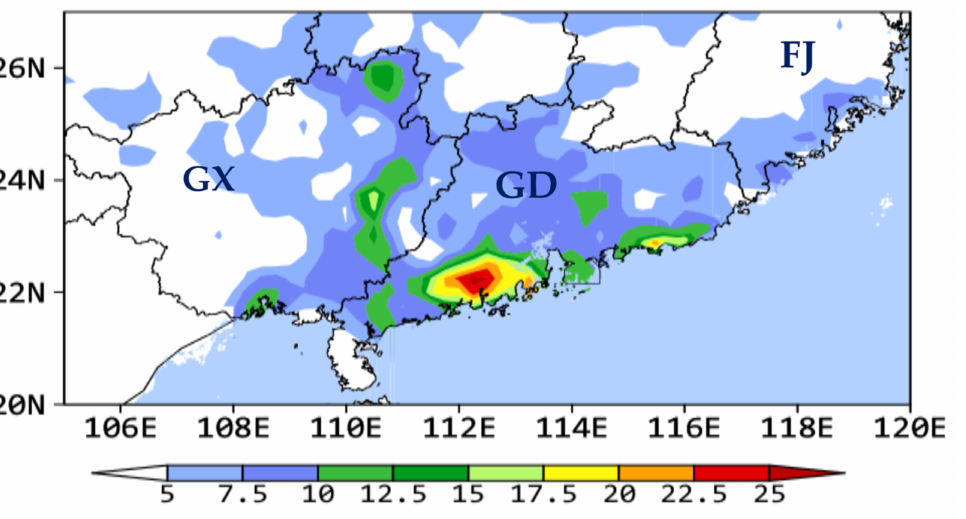
Figure 6. As in Figure 4, except for the 24 WMF-type WSHR events. As compared to the PSF-type of WSHR events, the WMF-type composite height field at 500 hPa is characterized by a distinct short-wave trough with the lower-tropospheric warm advection on the lee side of the Tibet Plateau with southwesterly flows over South China (Figure 7a). This would facilitate quasi-geostrophic ascent that helps bring the moist southwesterly monsoonal air underneath to saturation, thereby preconditioning the large-scale environment for HR production. The 850-hPa composite fields show the presence of south-to-southwesterly winds of up to 10 m s − 1 with θ e > 340 K over a vast area on the south of the Yangtze River Basin, including South China. Unlike the PSF-type events, there is little evidence of a low-level shearline or a front-like zone. Thus, it is often hard to trace directly the initiation of MCSs associated with the WMF-type of WSHR events. An examination of Figures 1, 6 and 7a shows that the above-mentioned WSHR maxima coincide reasonably well with the land-ocean contrast and local topography. This indicates the importance of orographic lifting in triggering deep convection, and of the echo-training process in producing the subsequent HR. In addition, we may assume that convectively generated moist downdrafts, and old thermal boundaries from the